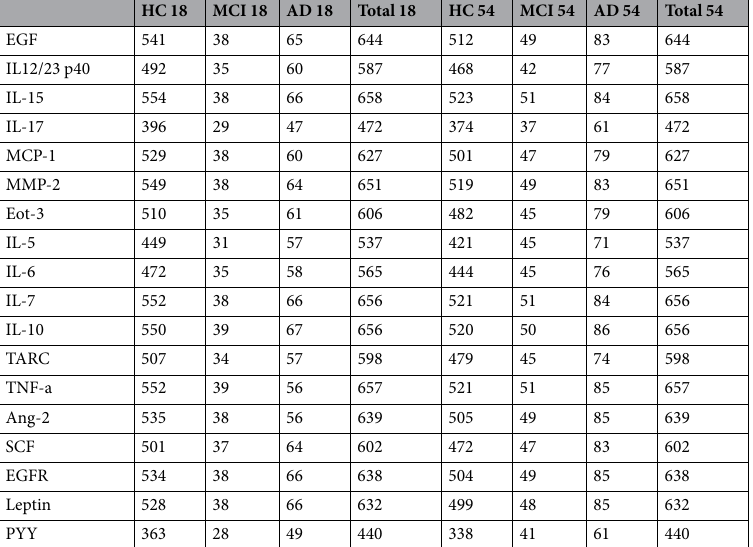
Table 2. Individual number of cases analysed for each single biomarker in our 3 groups (HC, MCI,